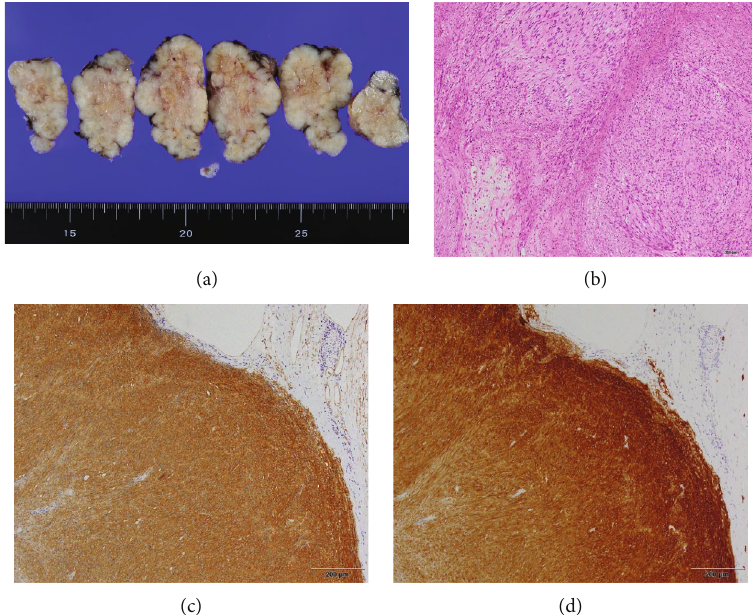
Figure 2: Pathological fi ndings. (a) Macroscopic fi ndings: the cut surface of tumor was smooth, light brown, and solid, and no necrosis was observed. (b) On hematoxylin and eosin staining: spindle-shaped cells with nuclear atypia were arranged in a bundle and had proliferated. (c, d) On immunohistochemistry examination: CD34 and CD117 (KIT) were